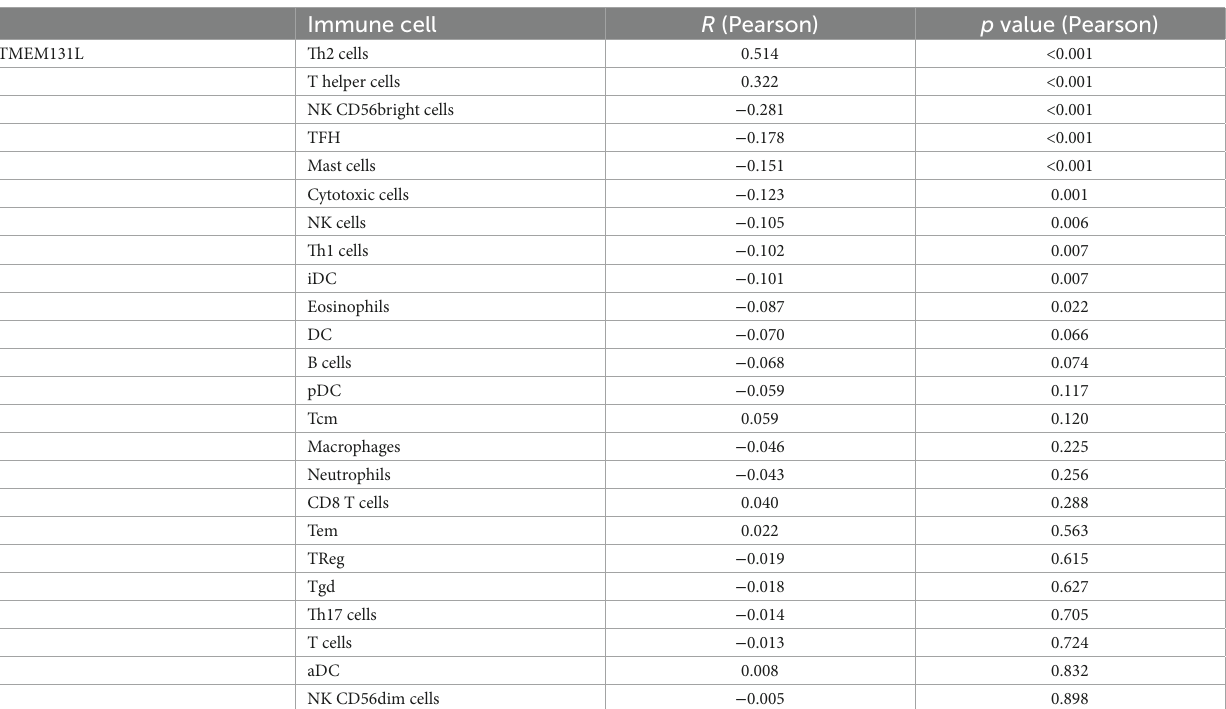
TABLE 3 Correlation between TMEM131L and immune cell